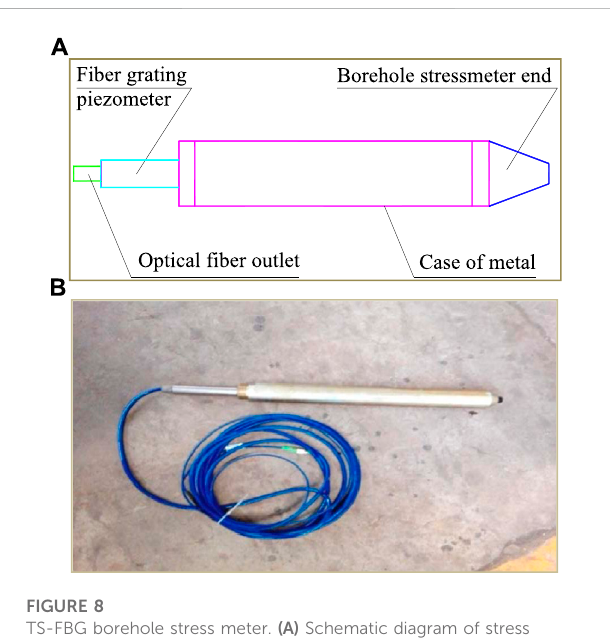
FIGURE 8 TS-FBG borehole stress meter. (A) Schematic diagram of stress meter. (B) Physical drawing of stress meter.